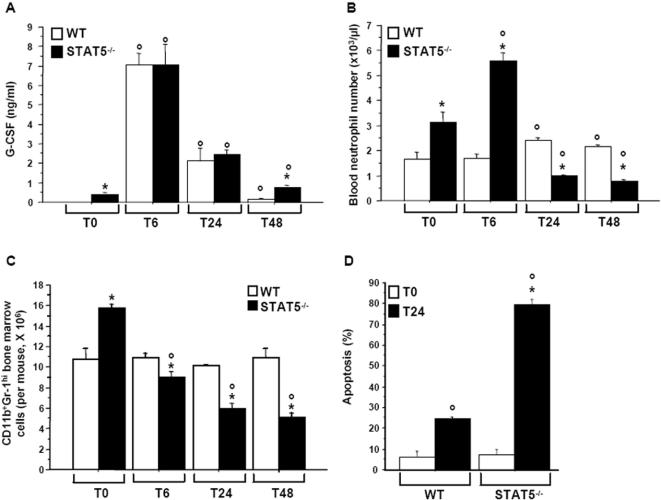
STAT5−/− mice are unable to maintain neutrophil homeostasis during cytokine-induced inflammation.(A) Wild-type (WT) and mutant mice were injected intravenously with 2 µg recombinant murine TNF-α and 2 µg recombinant murine IL-1β. Serum G-CSF concentrations were measured by ELISA before (T0) and 6 (T6), 24 (T24), and 48 (T48) hr after cytokine injection. (B) Blood neutrophils were counted at the different time points. (C) Mature marrow neutrophils (CD11c+Gr-1hi cells) from control and mutant mice were counted by flow cytometry. Absolute values were generated by multiplying gated percentages by total cell numbers. (D) Blood neutrophils were isolated by MACS from wild-type and mutant mice 24 hr after cytokine injection. Freshly purified (T0) and 24-hr cultured (T24) neutrophils were assayed for apoptosis using dual color annexin-V-FITC/propidium iodide staining and flow cytometry analyses. (A–D) *, significantly different from WT values with P<0.05. °, significantly different from T0 values with P<0.05.